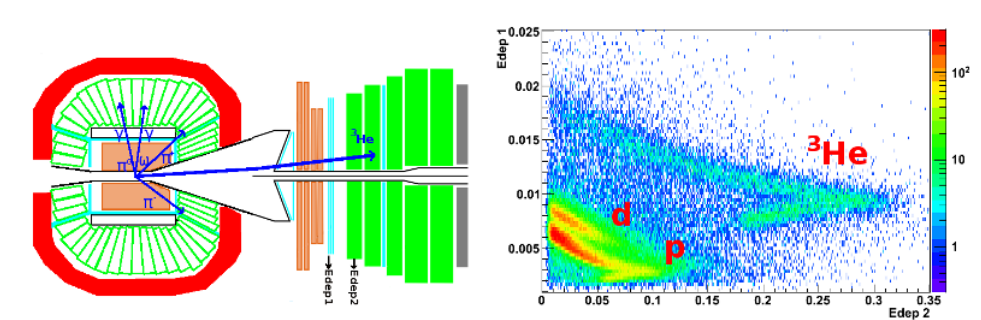
Fig. 1. Left: A schematic picture of the WASA detector with typical particle trajectories drawn. The short-lived decay particles are detected in the central part while the recoiling 3 He are detected in the forward part. Right: The energy deposit in one layer of the forward detector versus the energy deposit in a subsequent layer. Three bands are visible due to protons, deuterons and 3 He.